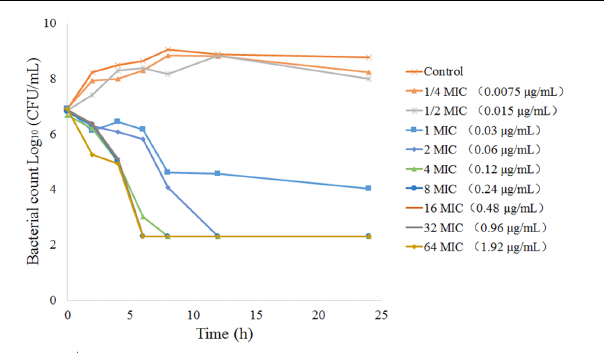
An isolate of P. multocida CVCC430 was grown freshly from beads stored at − 80 ◦ C on TSA. Five to eight colonies were used to inoculate 9 mL of MHB and the cultures were placed in shaking at 37 ◦ C overnight. Ex vivo bacterial